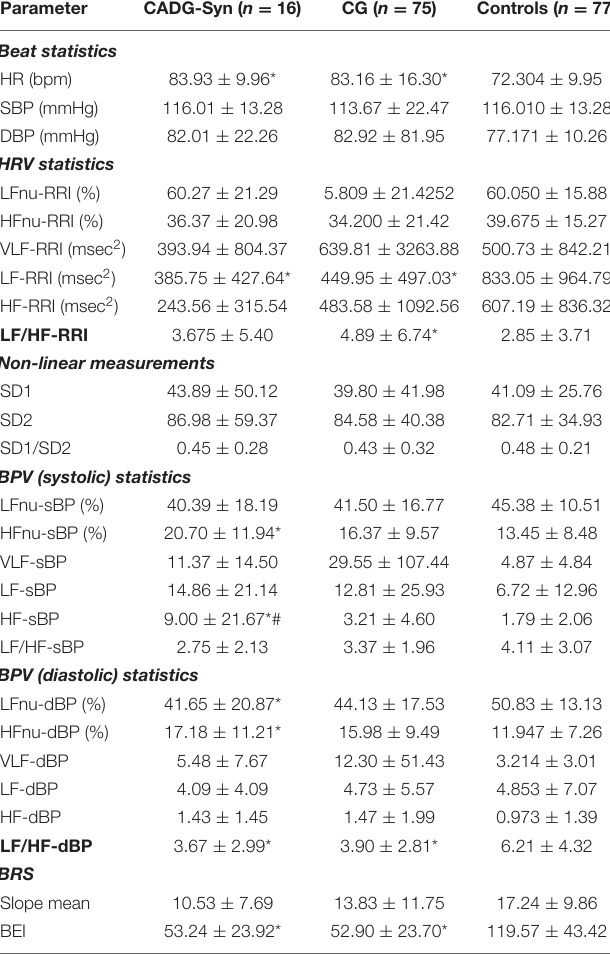
TABLE 8 | HRV and BPV in COVID-19 group with hypertension (CADG-HTA). Parameter